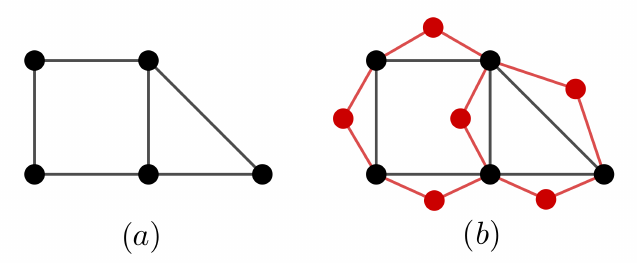
Figure 3. In ( a ) a graph G, in ( b ) graph R ( G ) .